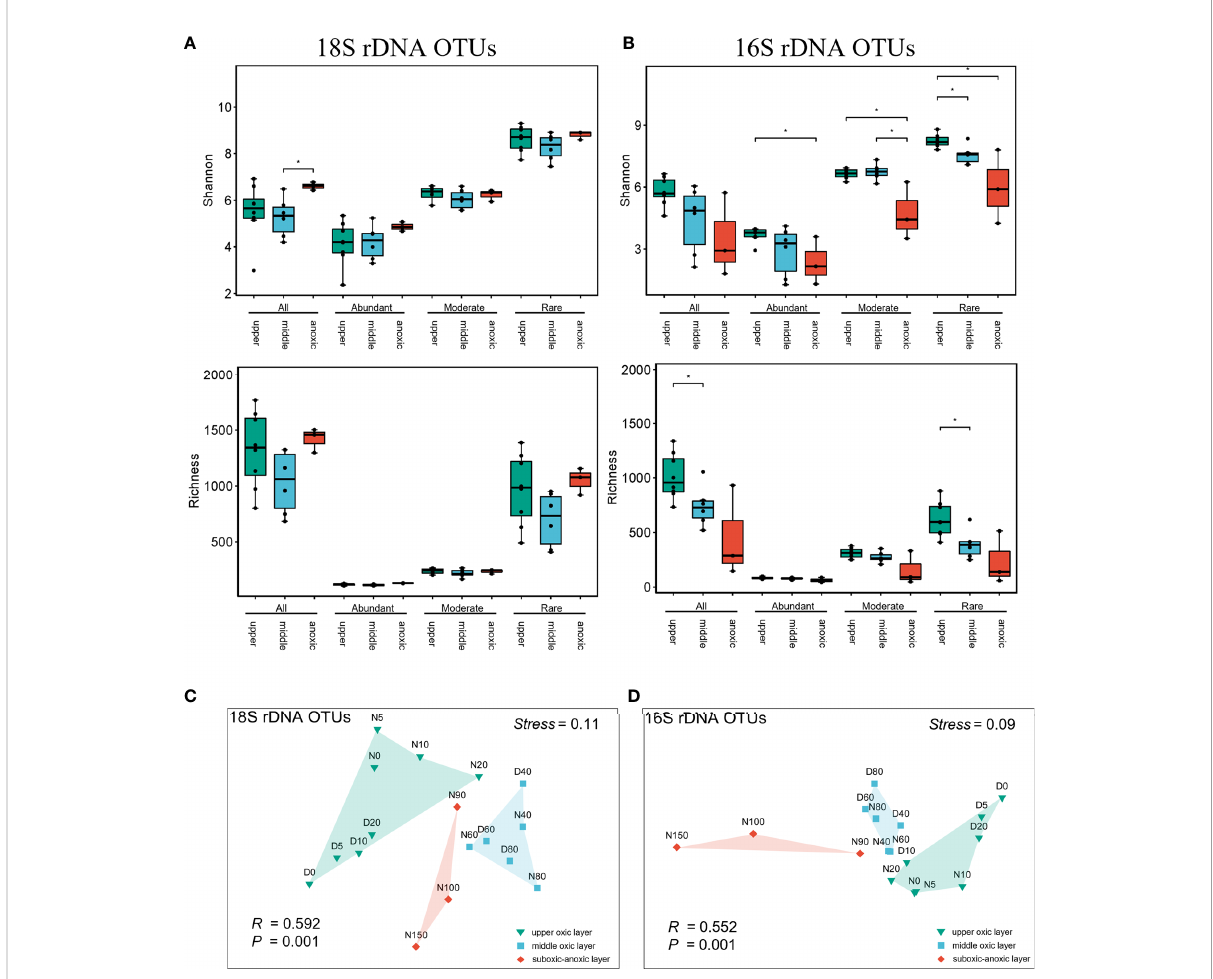
FIGURE 3 Community structuring of microeukaryotic and prokaryotic plankton in the SYBH. The richness and Shannon Index of microeukaryotic (A) and prokaryotic (B) plankton communities. The error bars indicate SD, and asterisks (*) indicate signi fi cant differences at the level of P <0.05. (C, D) Non-metric multidimensional scaling (NMDS) ordination of plankton communities based on Bray – Curtis distances. upper, upper oxic layer; middle, middle oxic layer; anoxic, suboxic-anoxic layer. All, whole community; Abundant, Moderate and Rare indicate the abundant, moderate and rare plankton subcommunities,